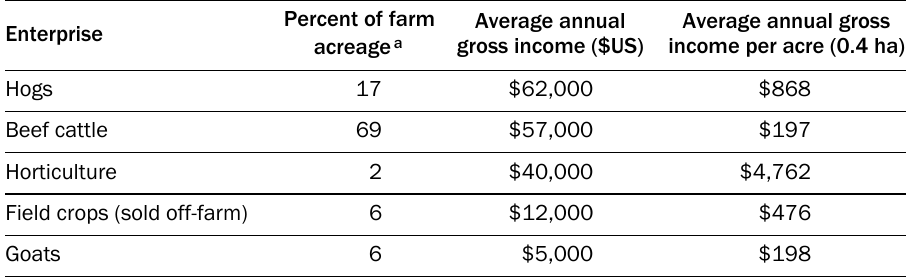
Table 2. Berea College Farm Enterprises, Average Percentage of Land Dedicated to Each, and Average Annual Gross Income During the